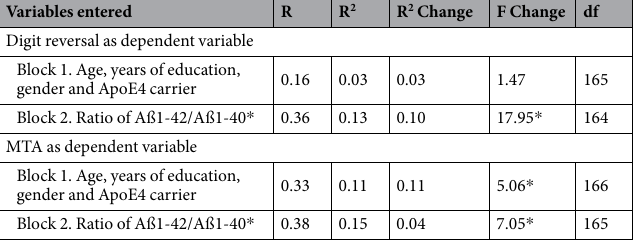
Table 4. Summary of regression analyses for ratio of Aß1-42/Aß1-40 predicting digit reversal and MTA in patients with AD. AD, Alzheimer’s dementia; CDR-SB, clinical dementia rating sum of boxes; ApoE,